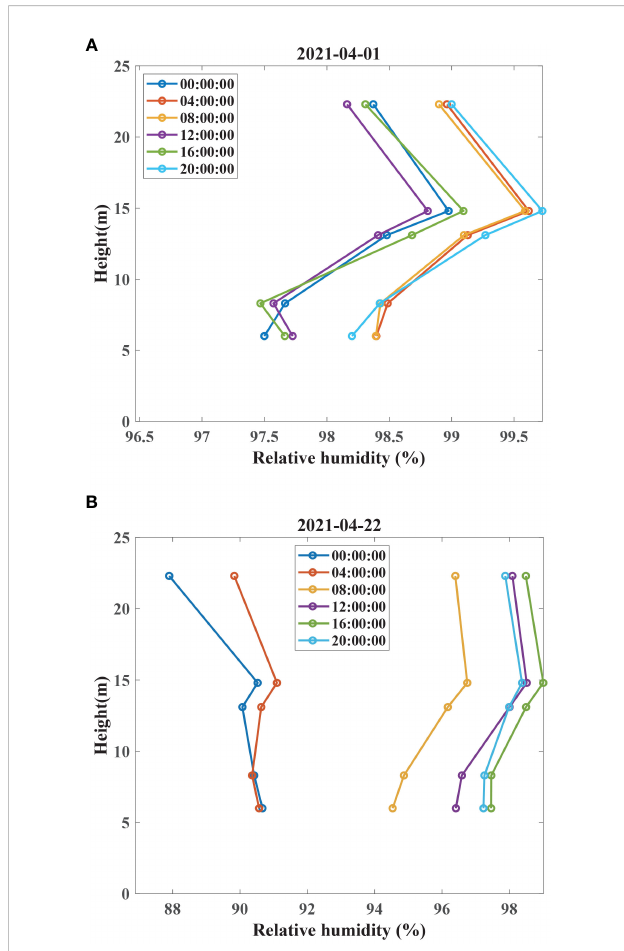
FIGURE 5 Change trends of the RH pro fi le on different days and at different times of the day. (A) 01 April 2021; (B) 22 April 2021.